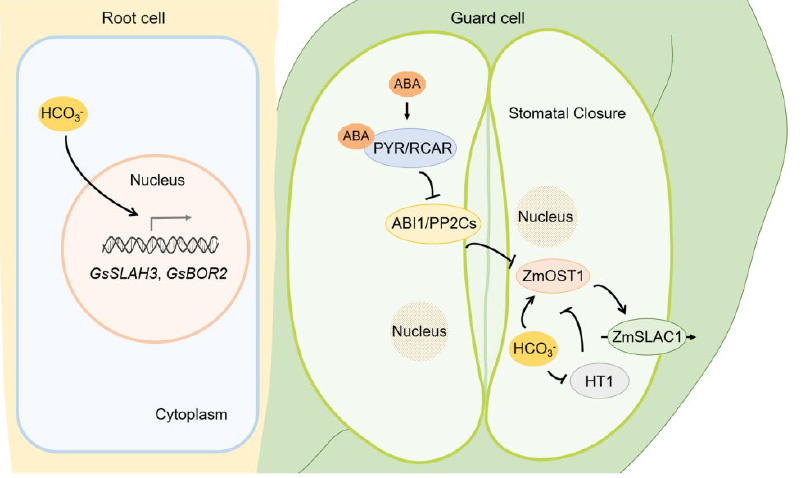
Figure 3. The mechanism model of plant response to HCO 3 − /CO 3 2− stress induced by saline-alkali stress. HCO 3 − increased the transcript level of GsSLAH3 and GsBOR2 in root, thus promoted the saline-alkali tolerance. Saline-alkali stress induced the accumulation of ABA, which binds the sensor PYR/RCAR and forms a complex with protein PP2C, then release protein kinase OST1 to activate anion channels SLAC1. HCO 3 − also functions as small molecule to active OST1, thus mediates stomatal closure in guard cell and promotes osmotic stress tolerance induced by saline-alkali stress. HT1 protein kinase functions as a negative regulator of high HCO 3 − induced stomatal closing.